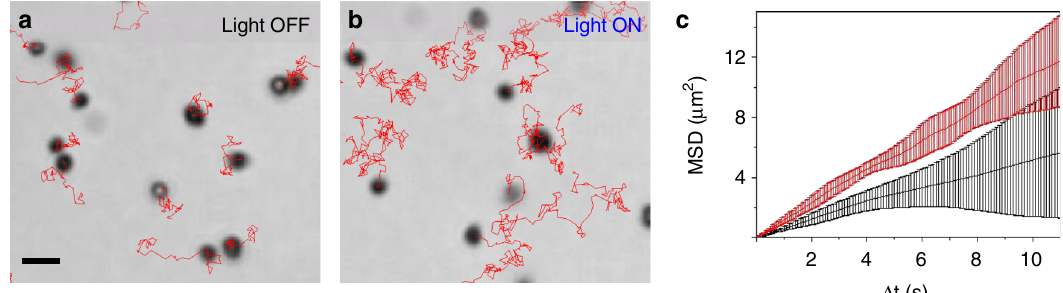
Fig. 1 Low motility of the chemically active titania particles. Top-down view of the motion of TiO 2 particles, sedimented at the bottom of a drop of hydrogen peroxide solution, at low areal number density (<4% of the area is covered by the particles): a standard Brownian motion in the absence of UV illumination; b enhanced diffusion due to self-propulsion upon illumination with UV light; c the mean squared displacement (MSD) determined from the particle trajectories as in a (black, lower part) and b (red, upper part) tracked over 15 s. The images in a , b show an area near the projection of the center of the drop onto the plane of the glass wall. The scale bar corresponds to 5 μ m. The black disks correspond to the particles at the end of the tracked trajectories (red lines). In c the MSD( Δ t ) for each of the tracked trajectory in the absence or presence of UV illumination, respectively, is located within the corresponding black or red shaded region. Therein, the red and black lines indicate the corresponding mean